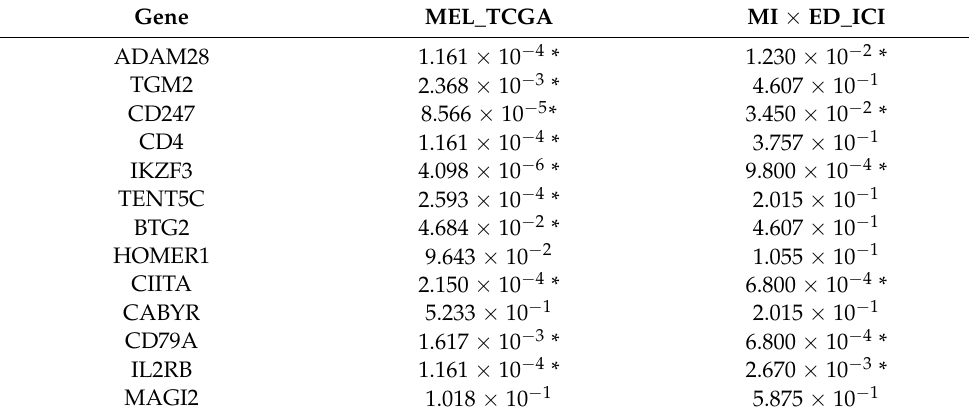
Table 3. Univariate risk stratification of MEL_TCGA ( n = 390) and MIXED_ICI ( n = 174) by overall survival with BIO_13. Log-rank test q-values are shown for risk stratification with groups defined by regularised Gaussian mixture modelling (please see methods). Asterisks (*) indicates q -value <